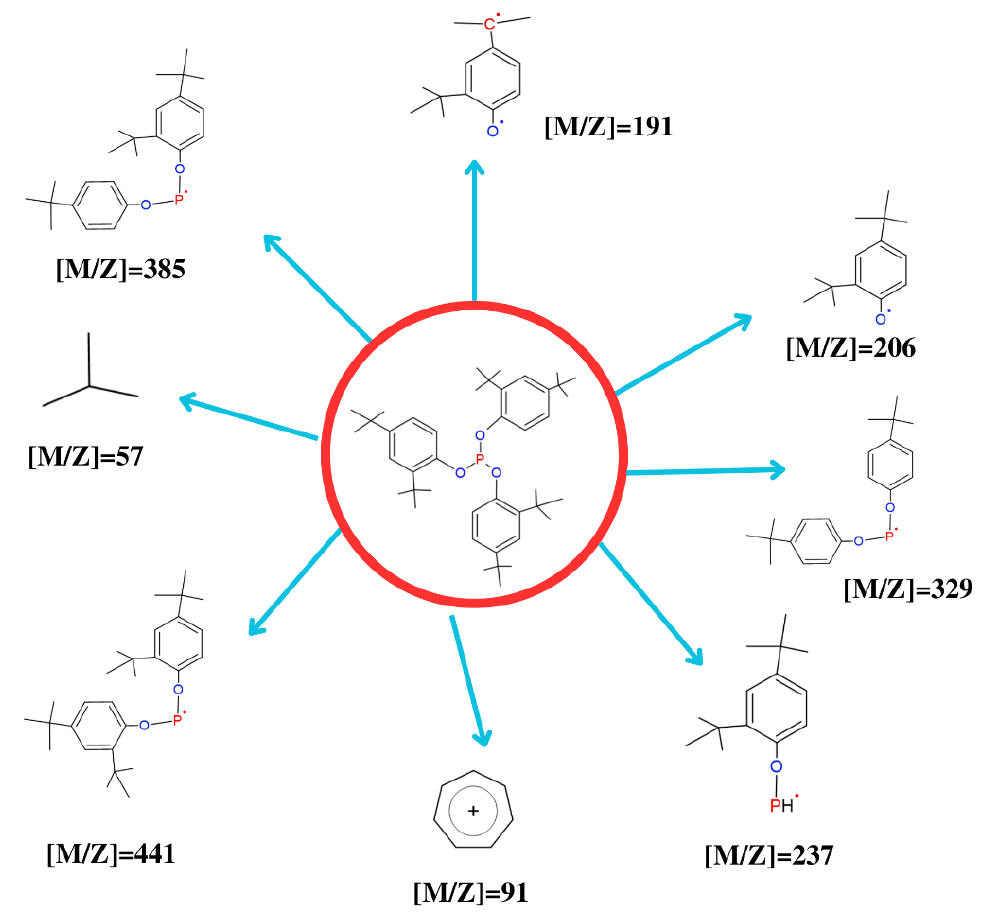
Figure 12. Structure of molecular ions from the fragmentation of Irgafos P-168.